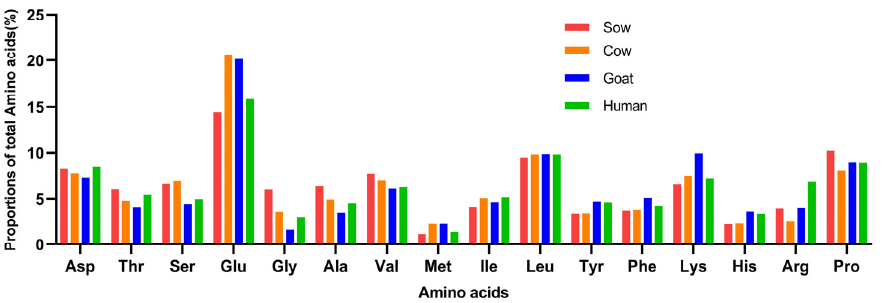
Figure 2. Amino acid profile of milk across animal species (% of total amino acids) (Ceballos et al., 2009, Garcia-Rodenas et al., 2016, Gu et al., 2020).